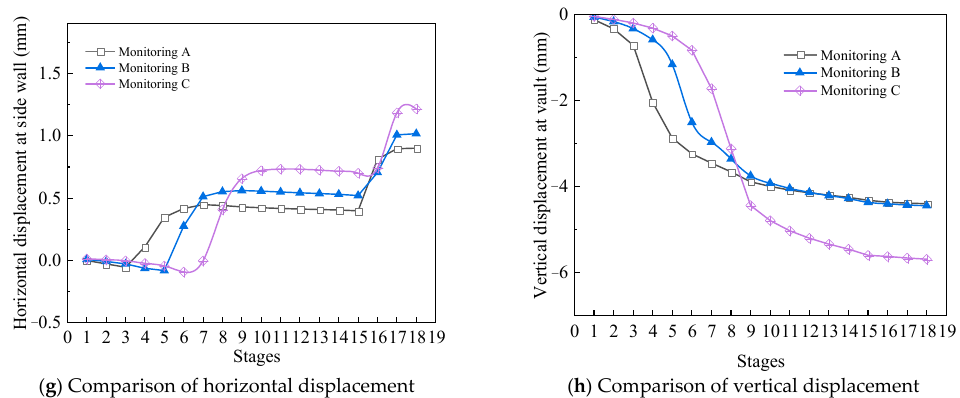
Figure 14. Horizontal and vertical displacement curves of surrounding rock at different monitoring sections.